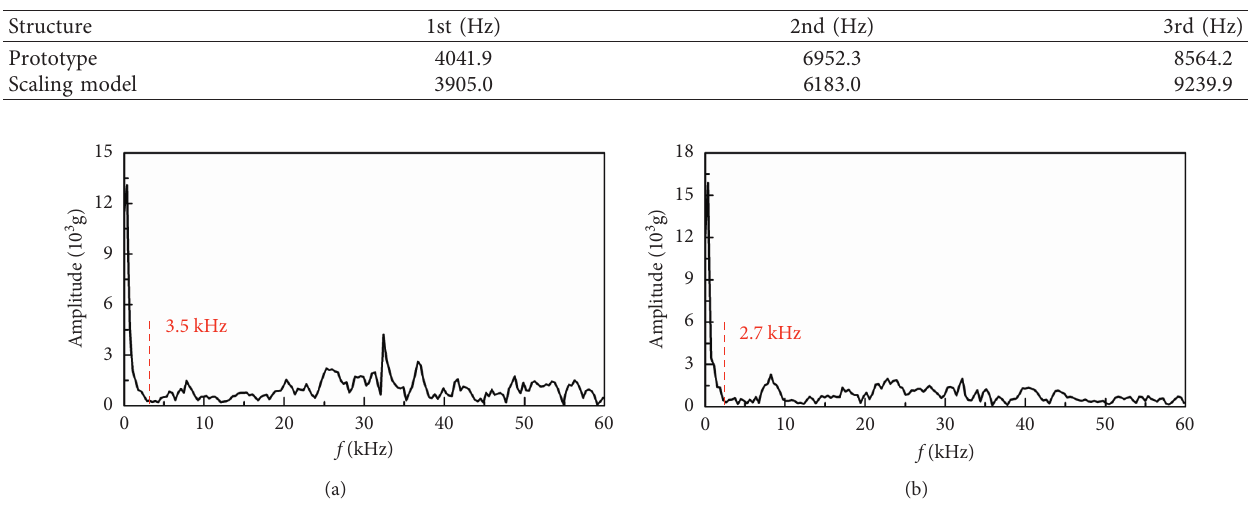
Figure 10: Spectrum of the deceleration-time curve of the (a) prototype and (b) nonproportional scaling model.